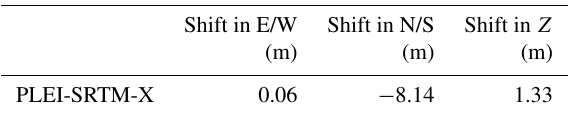
Table 2. Shifts used to co-register the PLEI DEM with the SRTM-X DEM. Shift in E/W Shift in N/S Shift in Z (m) (m) (m) PLEI-SRTM-X 0.06 − 8.14